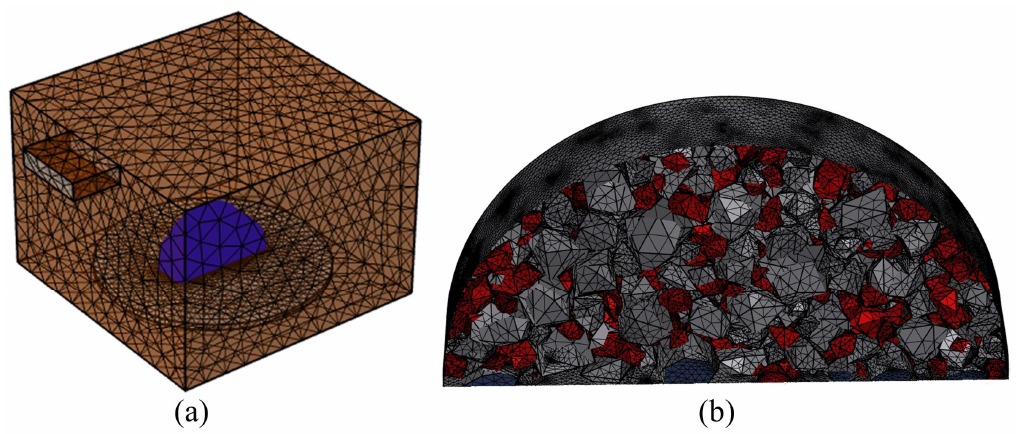
Figure 2. Mesh of the microwave heating model ( a ) and the specimen ( b ).